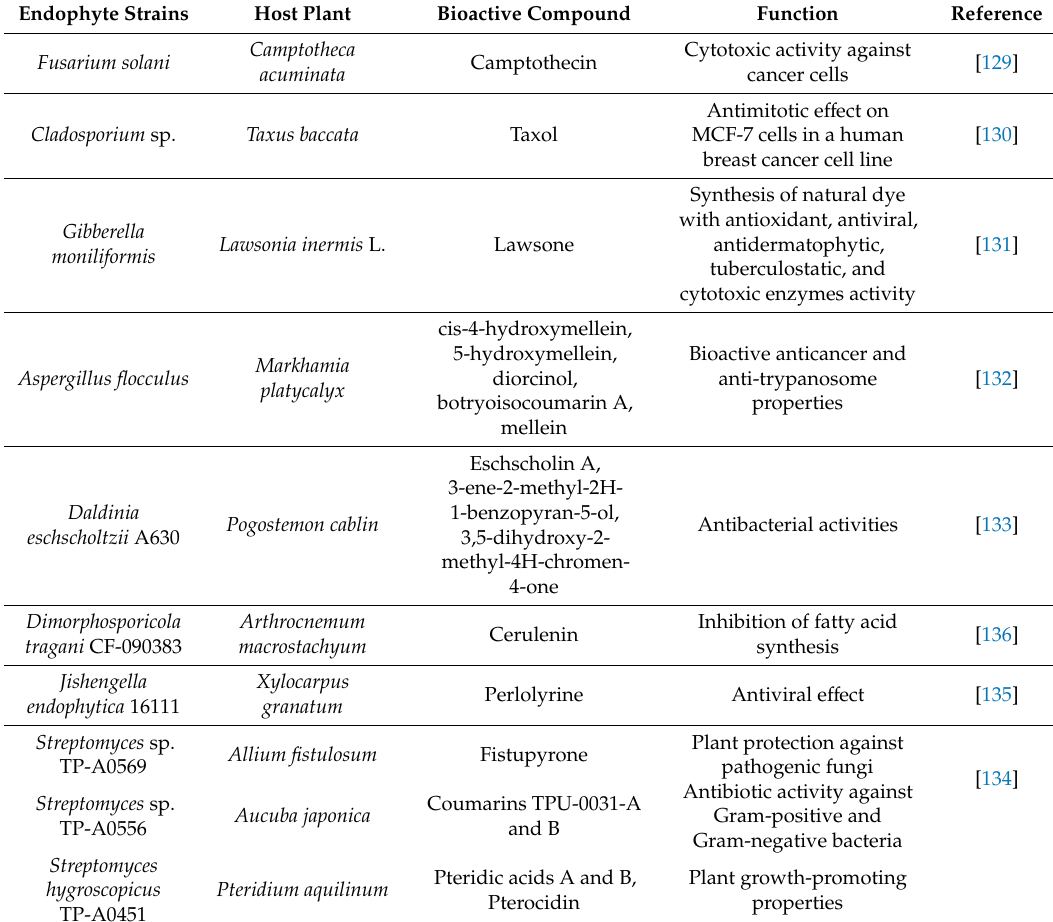
Table 4. Examples of endophytic strains, their host plant, synthesized bioactive compounds, and